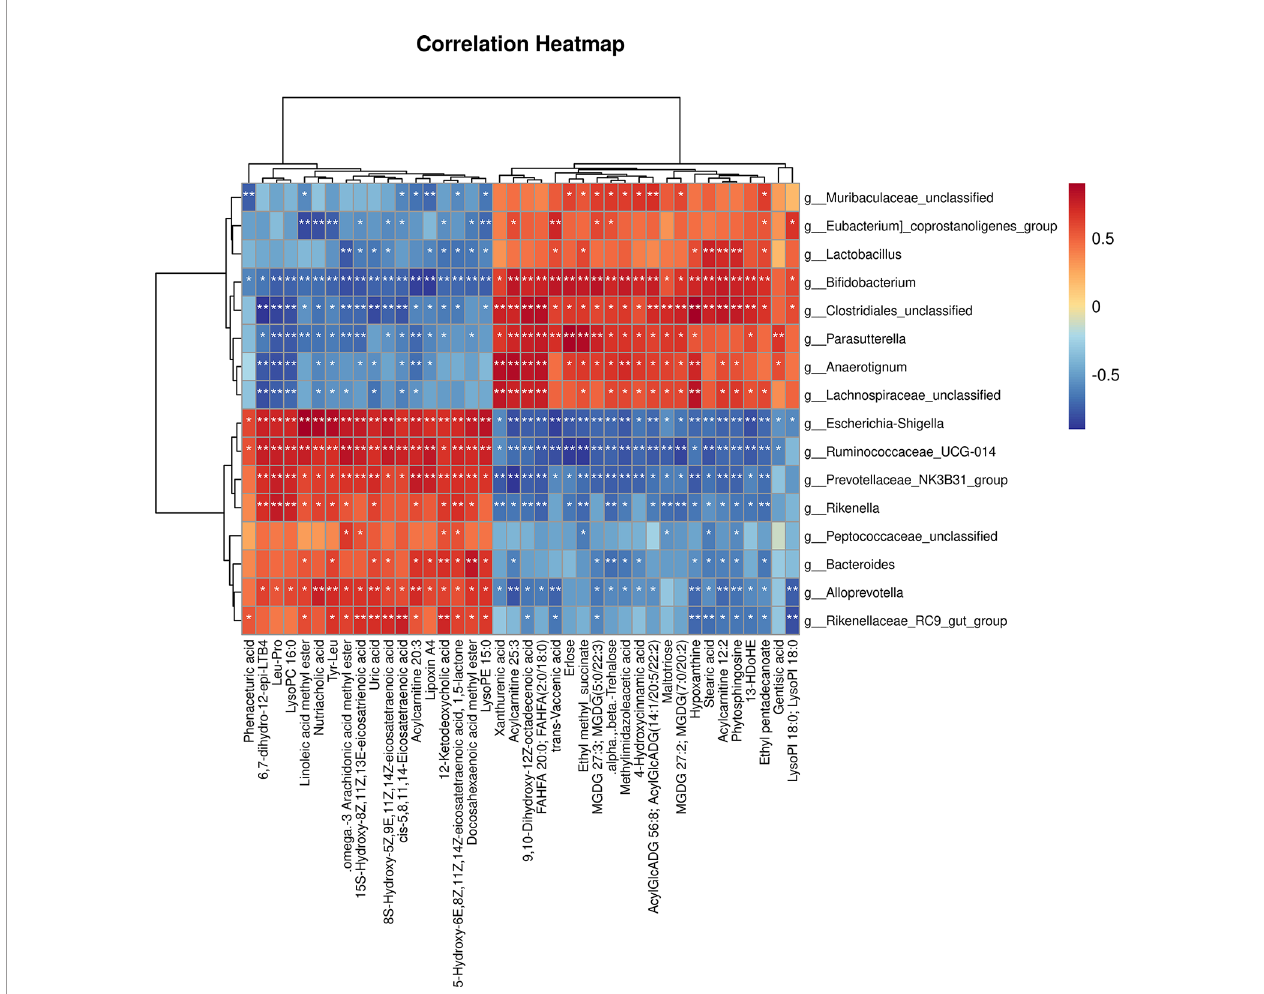
FIGURE 9 | Correlation analysis of the gut microbiome and fecal metabolites as well as relationship. Spearman ’ s rank correlation between 16 most differential genera and 40 differential metabolites from AGP_AGG group vs CTX group. * P <0.05, ** P <0.01 denoted statistical signi fi cance between bacterial taxa and